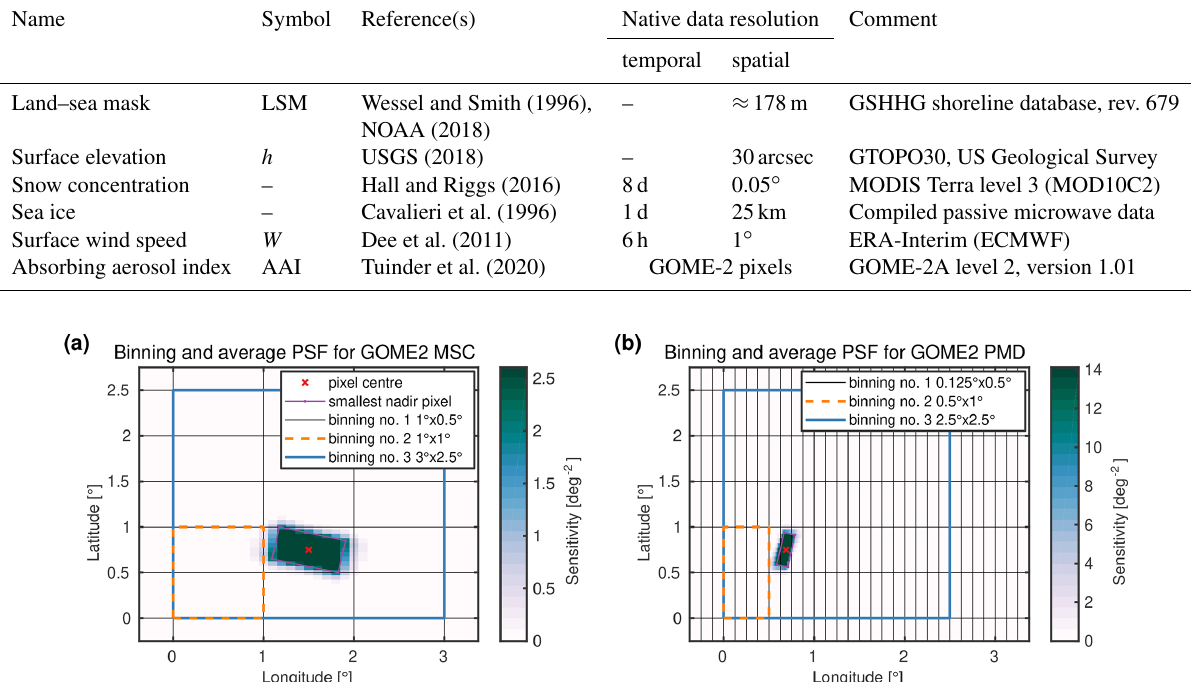
Table 3. List of external data sets applied in MICRU (see text for details).